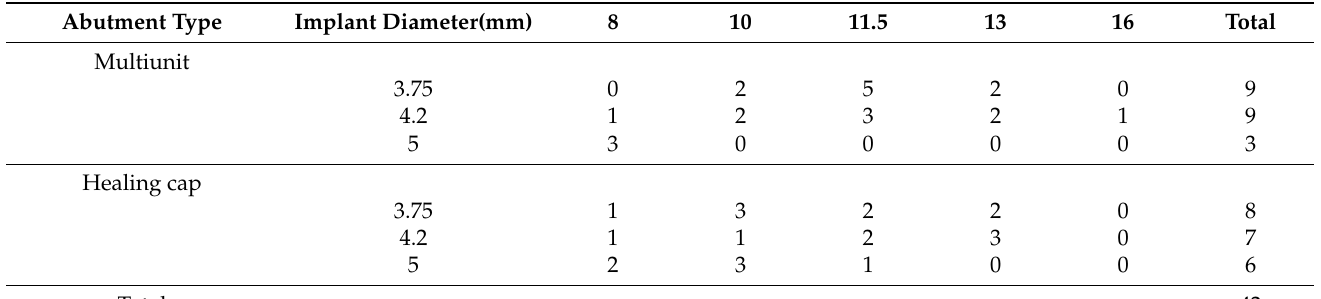
Table 3. Number of implants according to abutment and connection type (diameter and length in mm).